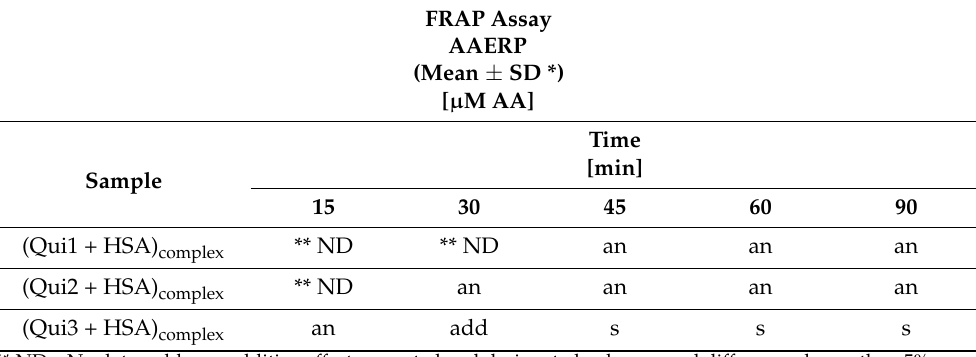
Table 12. Results of analysis of the type of interaction effect between Qui1–Qui3 and